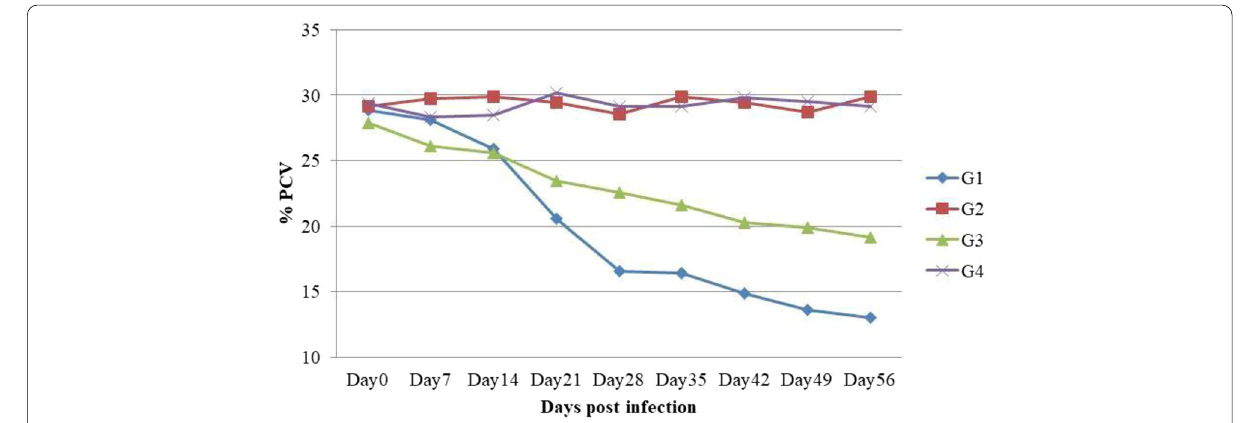
Fig. 3 Comparison of mean PCV values in the four experimental groups